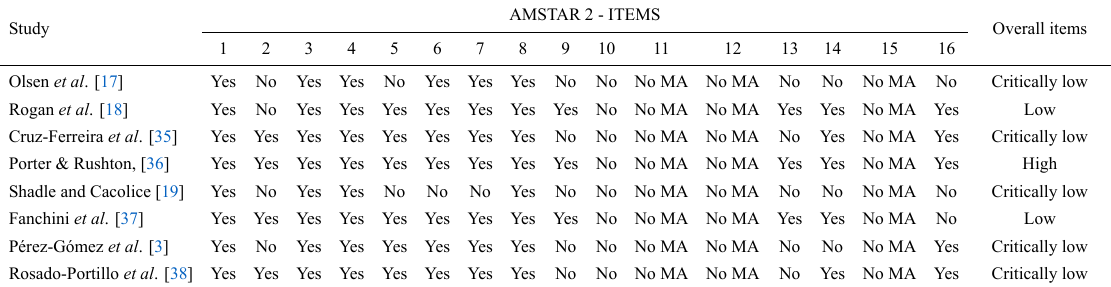
Table 4. AMSTAR 2 evaluation of each of the eligible studies included in the umbrella review.